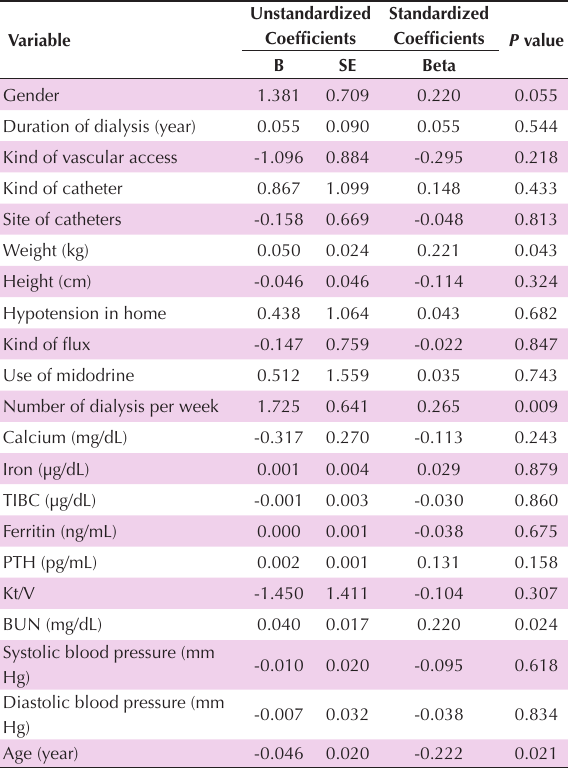
Table 5. Linear regression to predict the level of